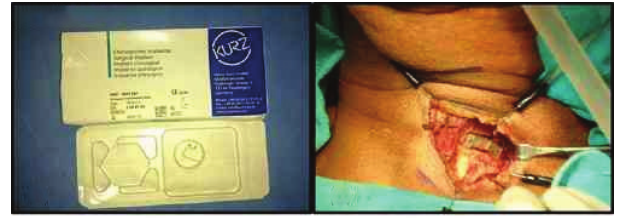
Figure 2 A, Titanium vocal fold medializing implant (TVFMI ® ). B, TVFMI ® placed in the cartilage